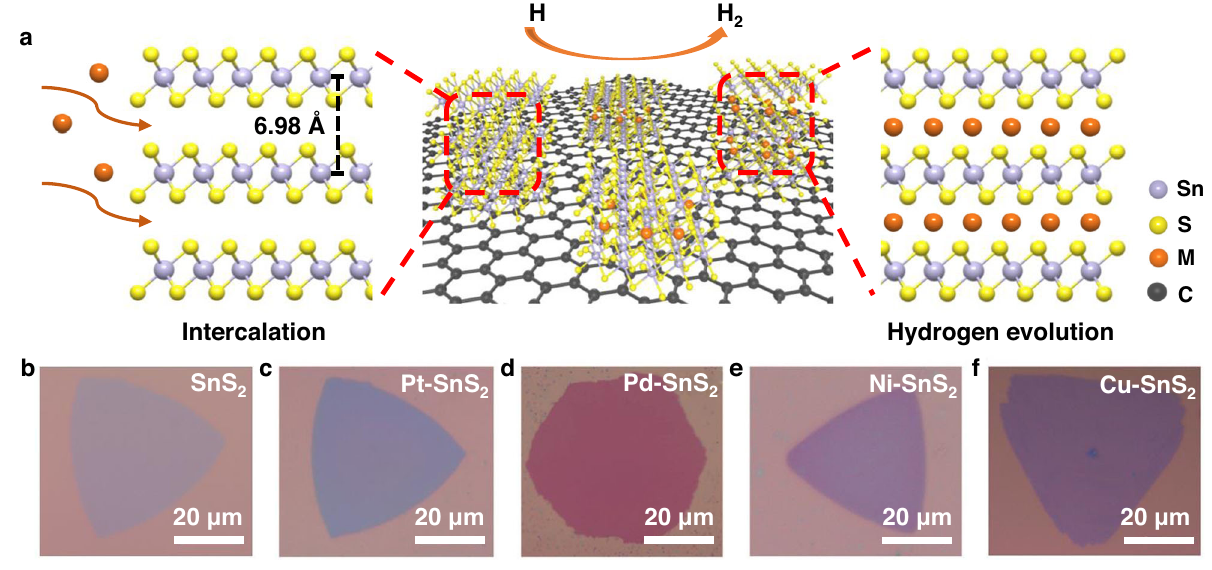
Fig. 1 | Realization of Pt-, Pd-, Ni-, and Cu-SnS 2 through a solution-based intercalationmethod.a SchematicillustrationoftheintercalationoflayeredSnS 2 . b – f Opticalimagesofpristinechemicalvapordeposition(CVD)grownSnS 2 ( b )and